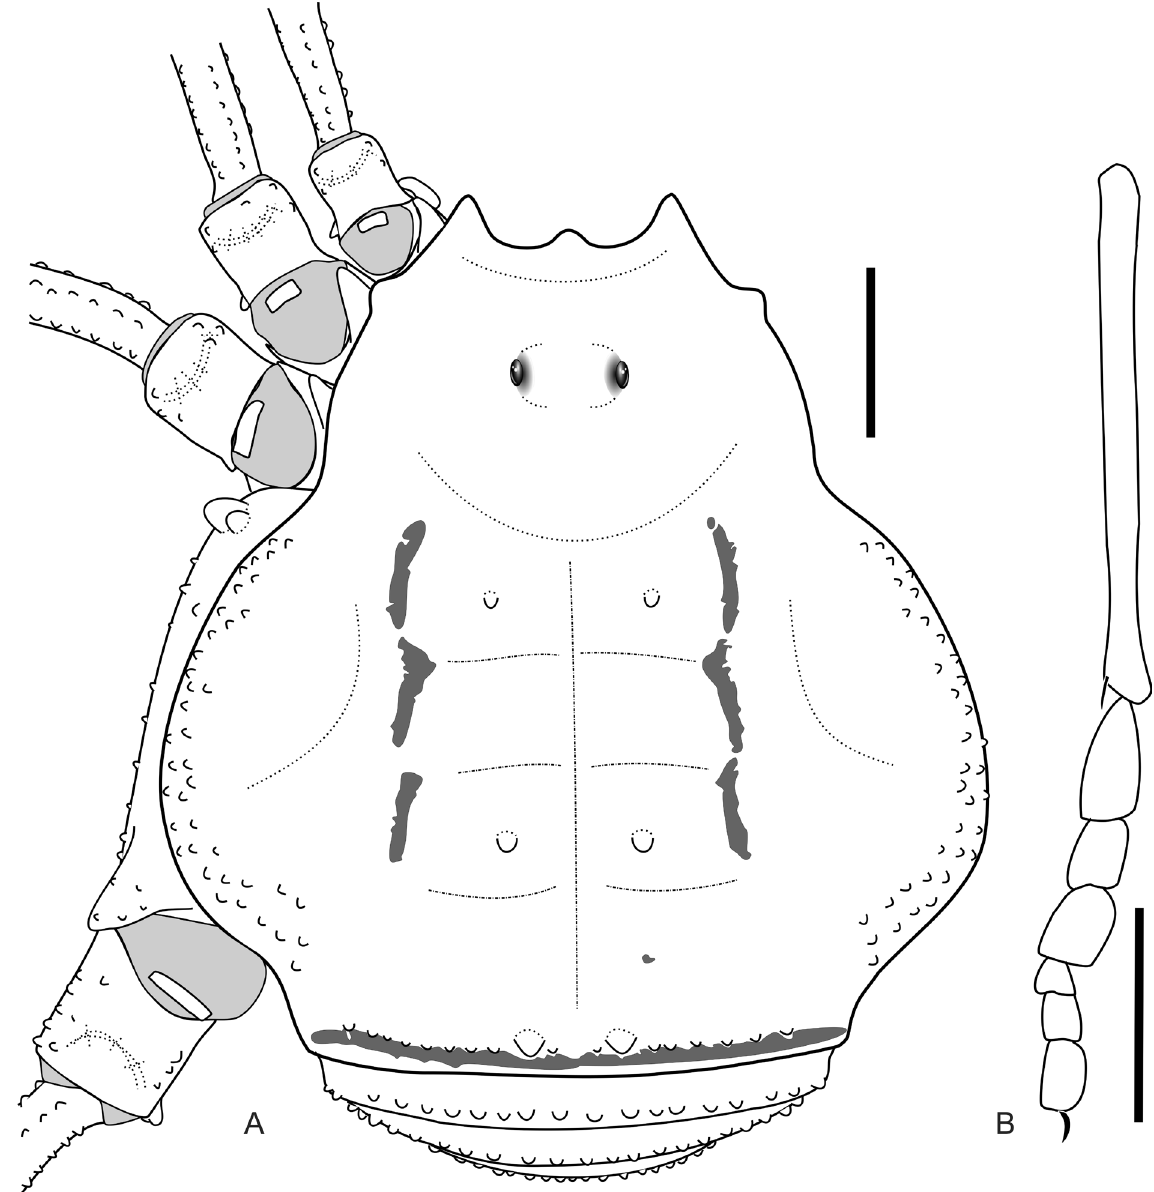
Fig. 16. Eulibitia leda sp. nov., ♂, holotype (ICN-AO 1165). A . Habitus in dorsal view. B . Left Mt and Ta of leg I, prolateral view. Scale bar: 1